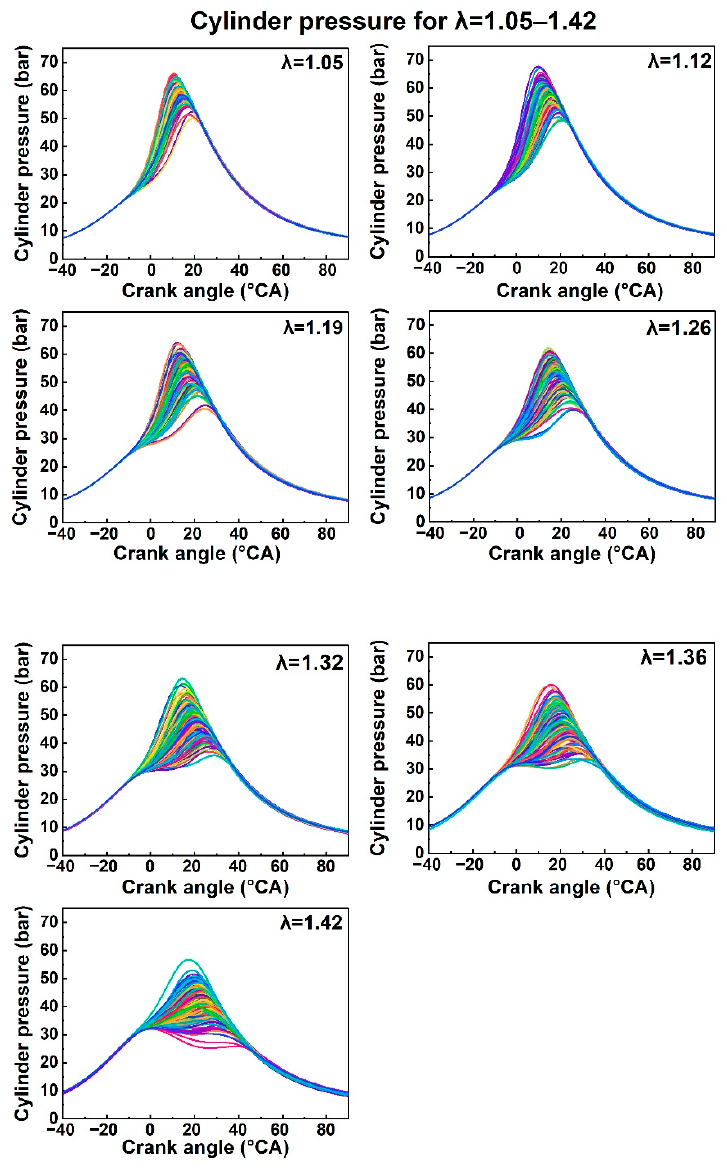
Figure 4. Cylinder pressure curves under different λ .